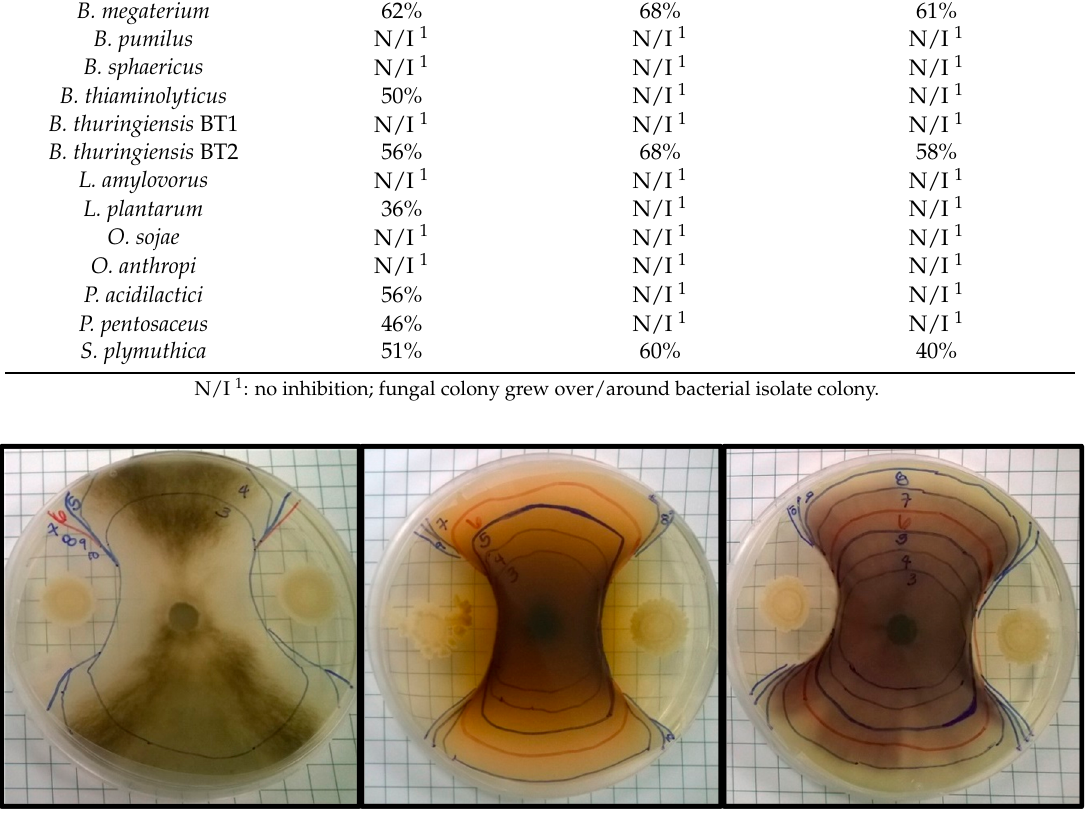
Table 2. Fungal inhibition of bioprotective isolates against Botrytis cinerea , Fusarium moniliforme , and Fusarium pallidoroseum after 10 d incubation at 24 °C.